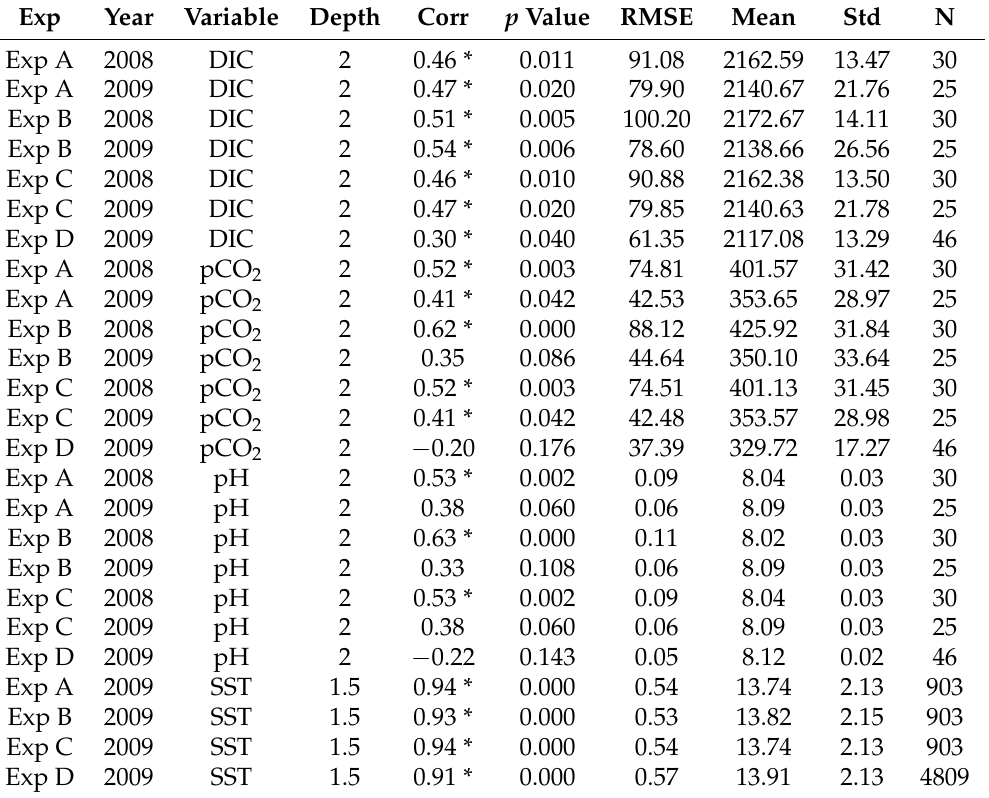
Table A4. Pearson correlations for experiments A–D, between observed and modeled variables for 2008–2009 at the shallowest depth available. Significant correlations at the 95% are indicated by